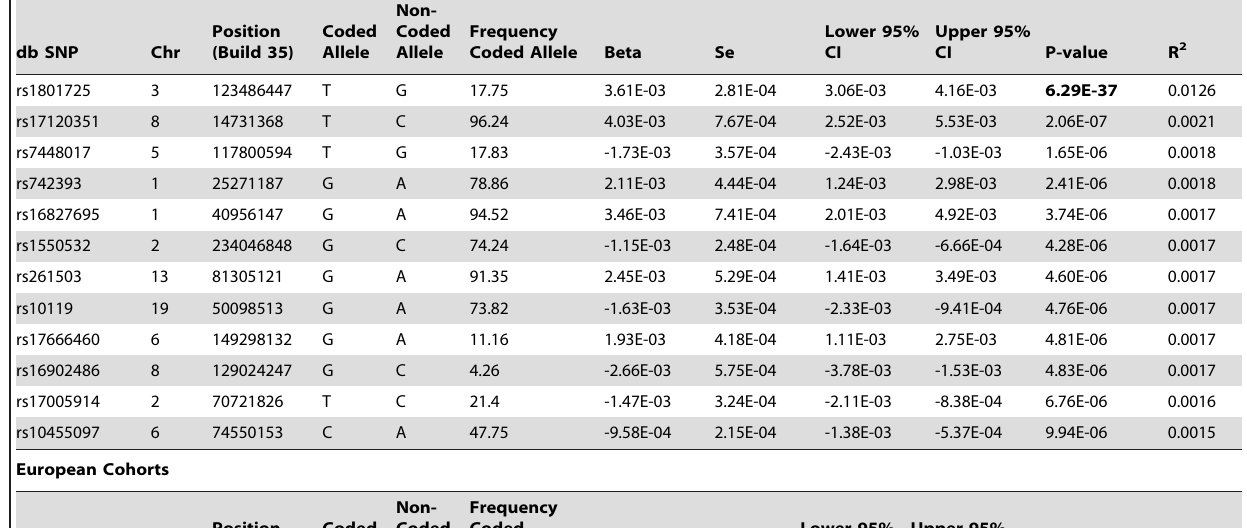
Table 3. Significance of top